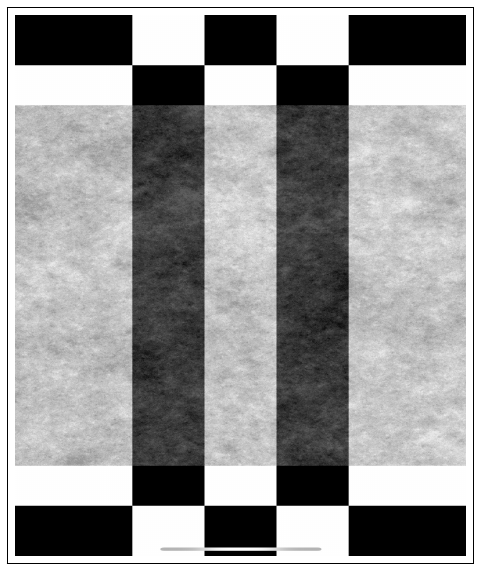
Figure 4. Realsense phone calibration tool [127].